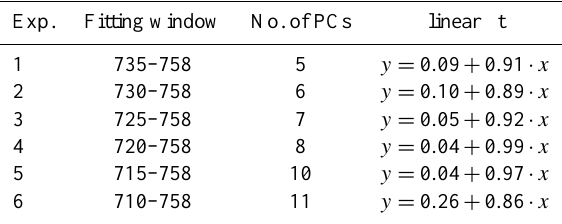
Table 1. Comparison of different retrieval windows. Shown is the linear fit (retrieved SIF = intercept + slope · input SIF) for supply- ing the most appropriate number of PCs (determined as in Fig.